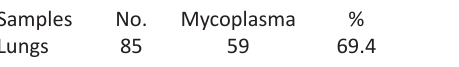
Table 3. Results of culturing of starlings lungs Samples No. Mycoplasma Lungs